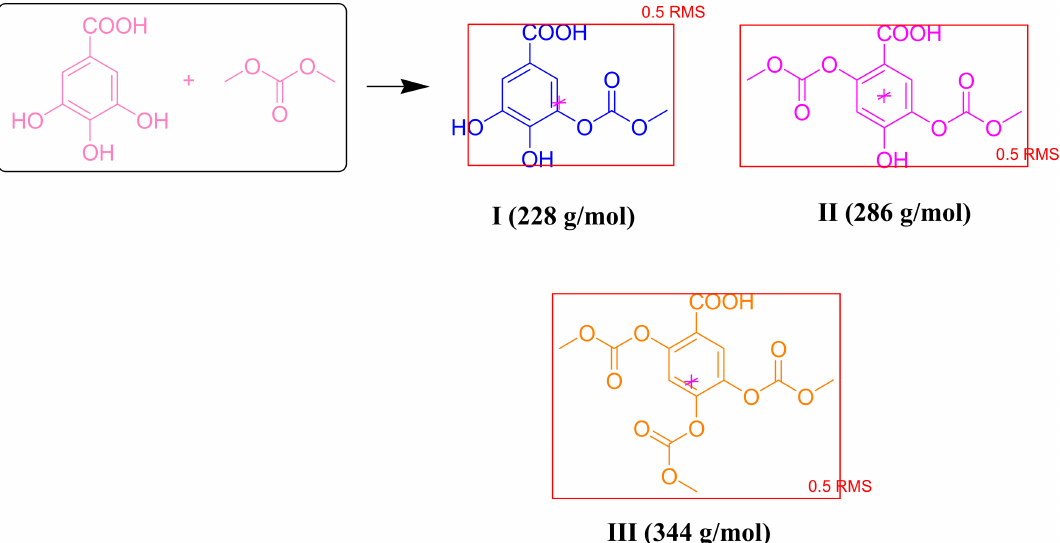
Figure 4. Major products with their respective mass molecules from the reaction between gallic acid and dimethyl carbonate [102].